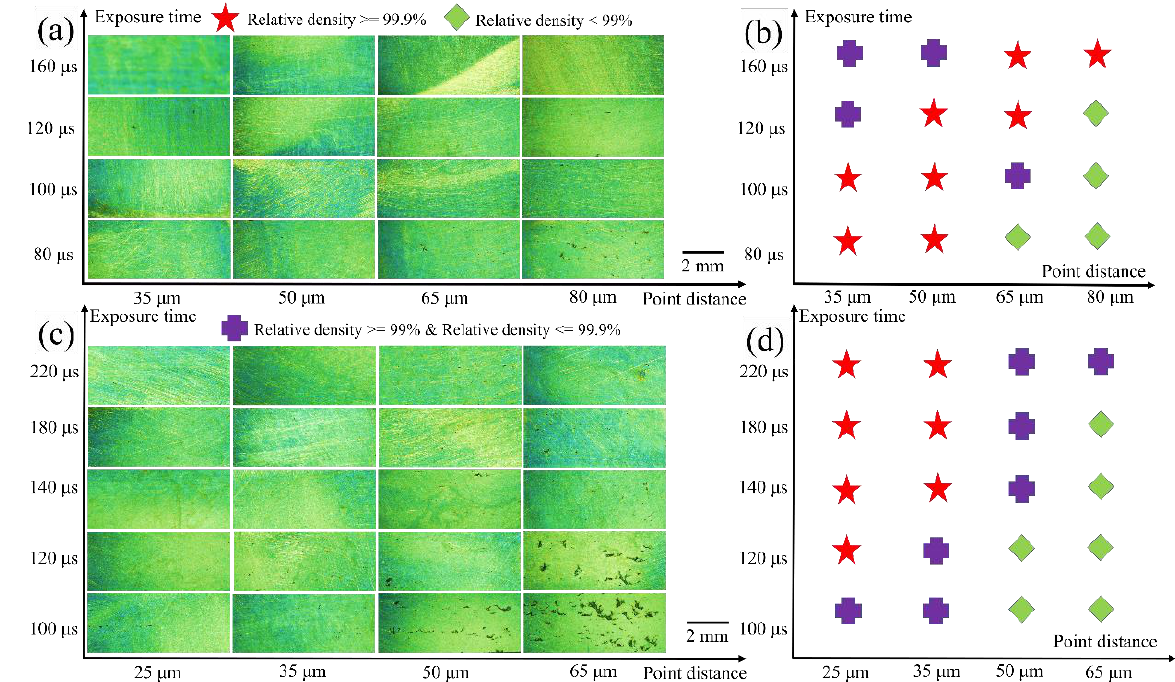
Figure 4. Specimen formed with 280 W laser power ( a ) the cross-sectional morphology of the specimen under the layer thickness of 50 μm ; ( b ) statistical results of ( a ); the cross-sectional morphology of the specimen under the layer thickness of 150 μm; ( d ) statistical results of ( c ).